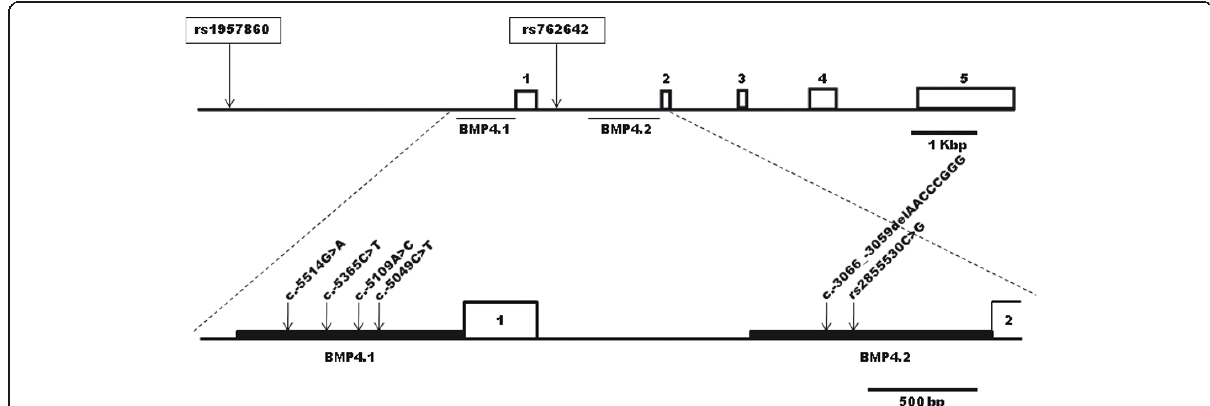
Figure 1 Basic structure of human BMP4 gene and their two promoters . Exons (boxes) are indicated by numbers 1 to 5. Upper panel shows the position of promoter 1 (BMP4.1) and promoter 2 (BMP4.2) and the location of the SNPs associated with NSCLP in a previous study (Suazo et al., 2010). Lower panel shows a more detailed view of the two promoters segment indicating the position of the novel and/or risk variants detected in the present